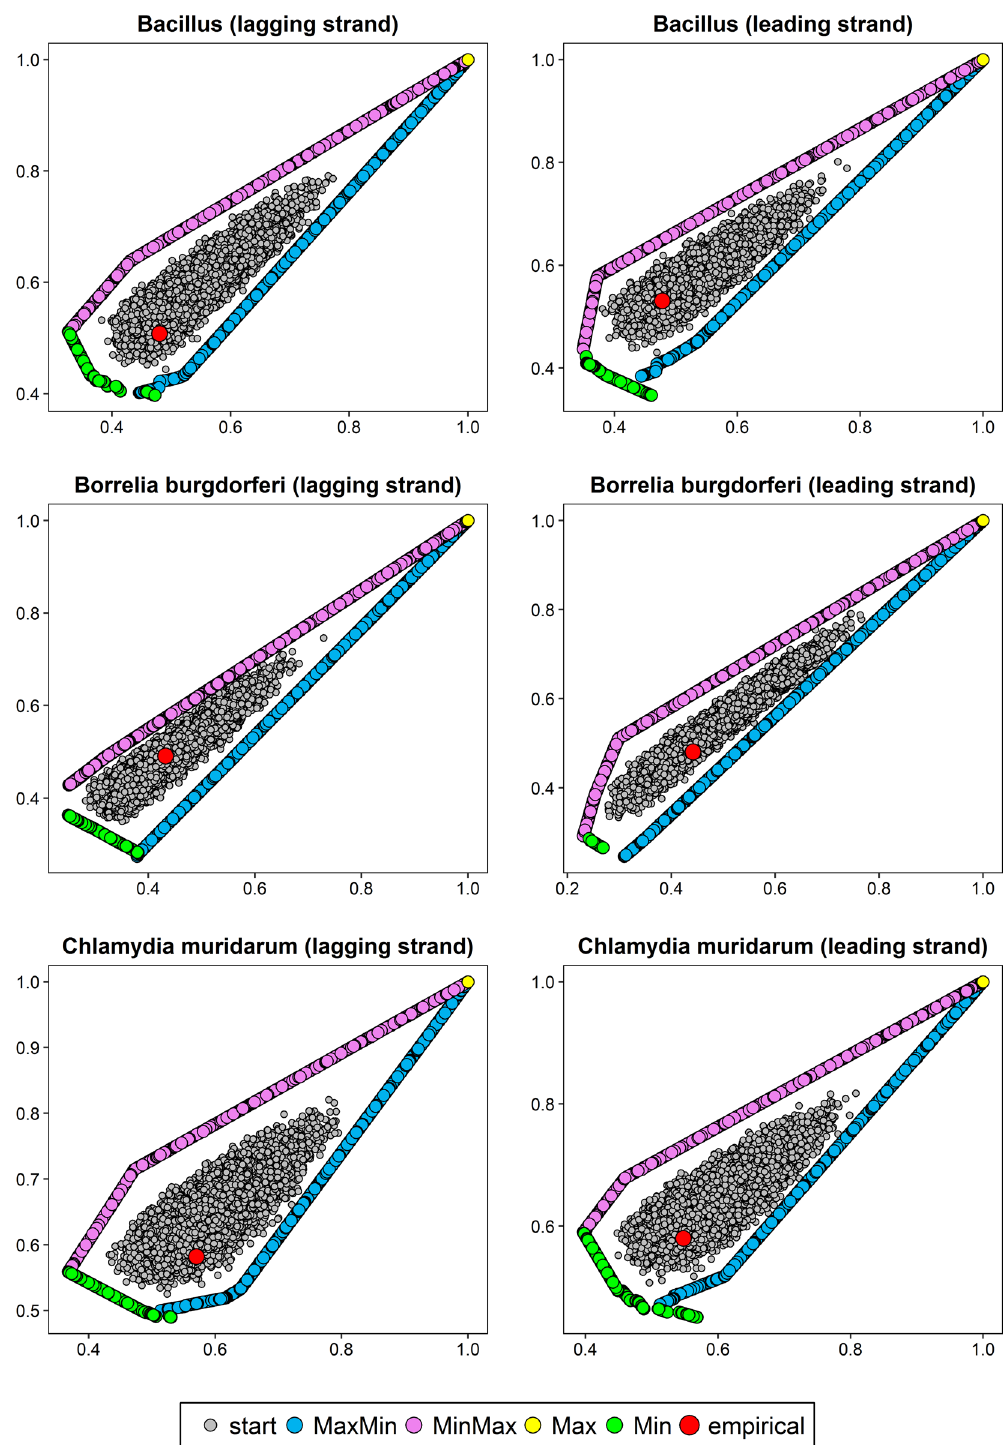
Figure 1. Comparison of costs of amino acid replacements in two physicochemical properties, hydropathy (x-axis) and polarity (y-axis) generated by: random started matrices (start), empirical matrices (empirical) and matrices maximizing hydropathy and minimizing polarity (MaxMin); minimizing hydropathy and maximizing polarity (MinMax) as well as maximizing (Max) or minimizing (Min) the both